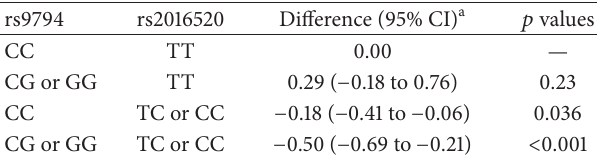
Table 5: Interaction analysis for two-locus